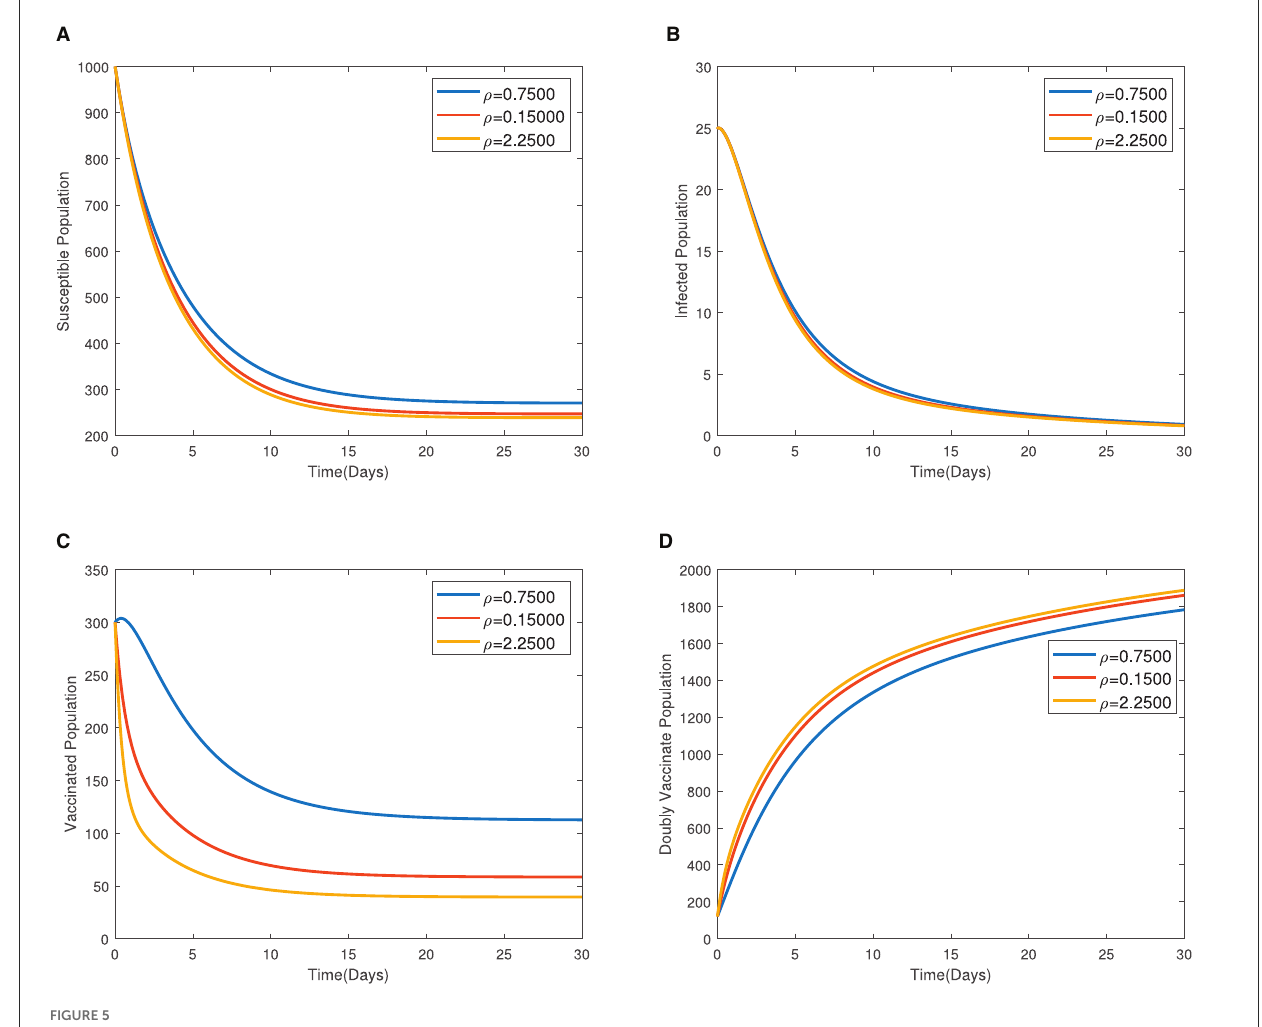
FIGURE5 (A–D) Time series plots showing the impact of administration of the booster dose of